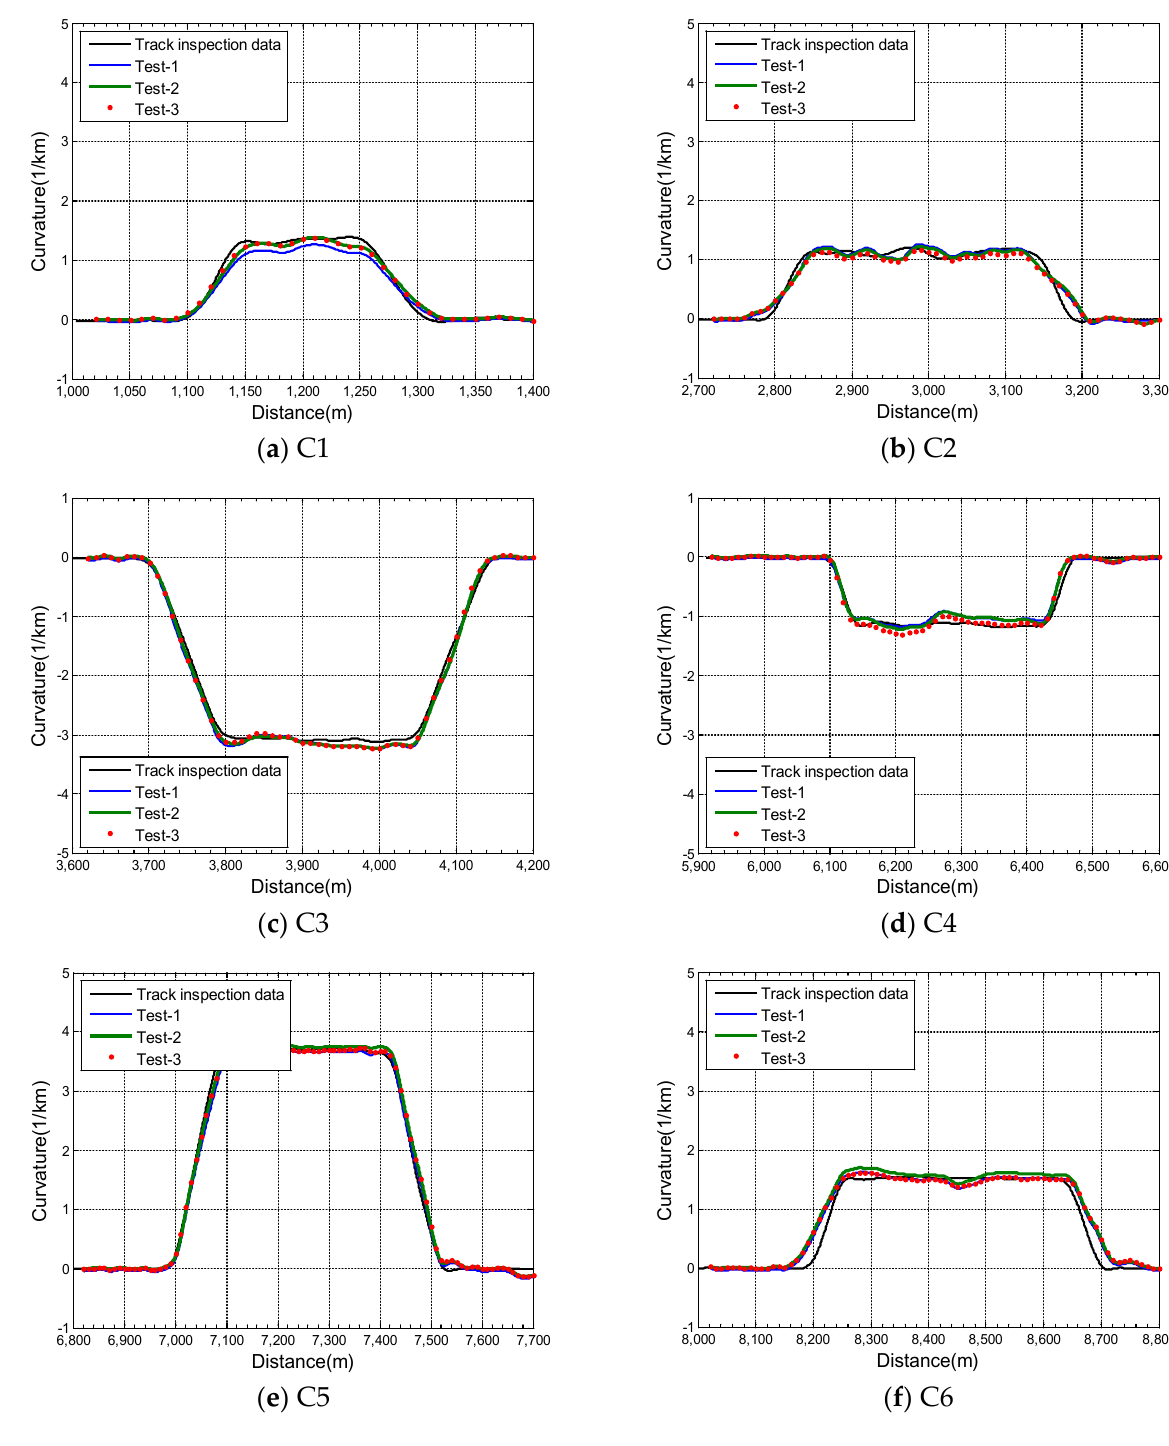
Figure 17. Curvature test result for each curve. Table 4. Curvature measurement results.